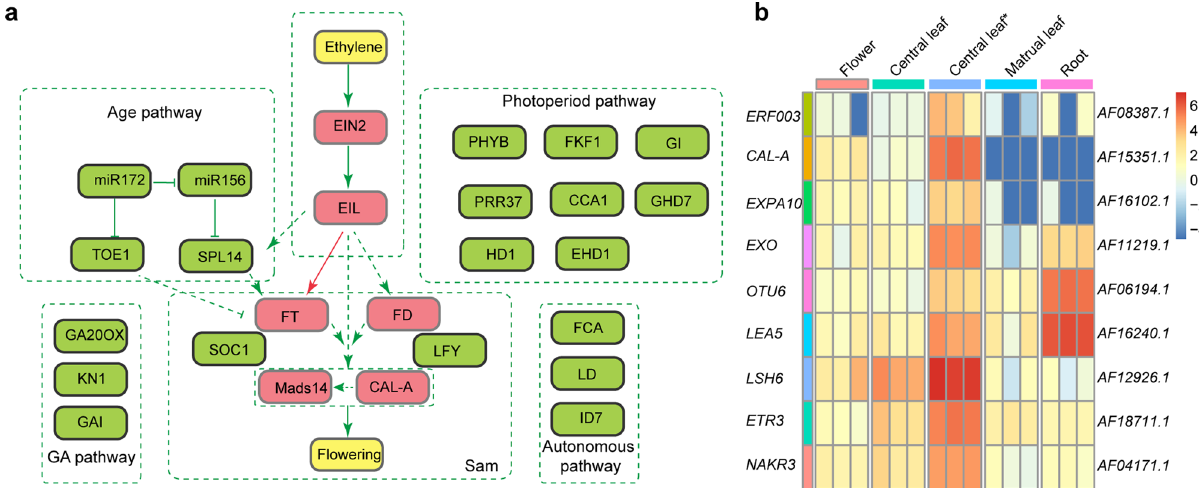
Fig. 6 A putative fl owering pathway in A. fasciata . a Putative fl owering pathway in A. fasciata. b Heatmap of putative genes synchronizing fl owering in A. fasciata